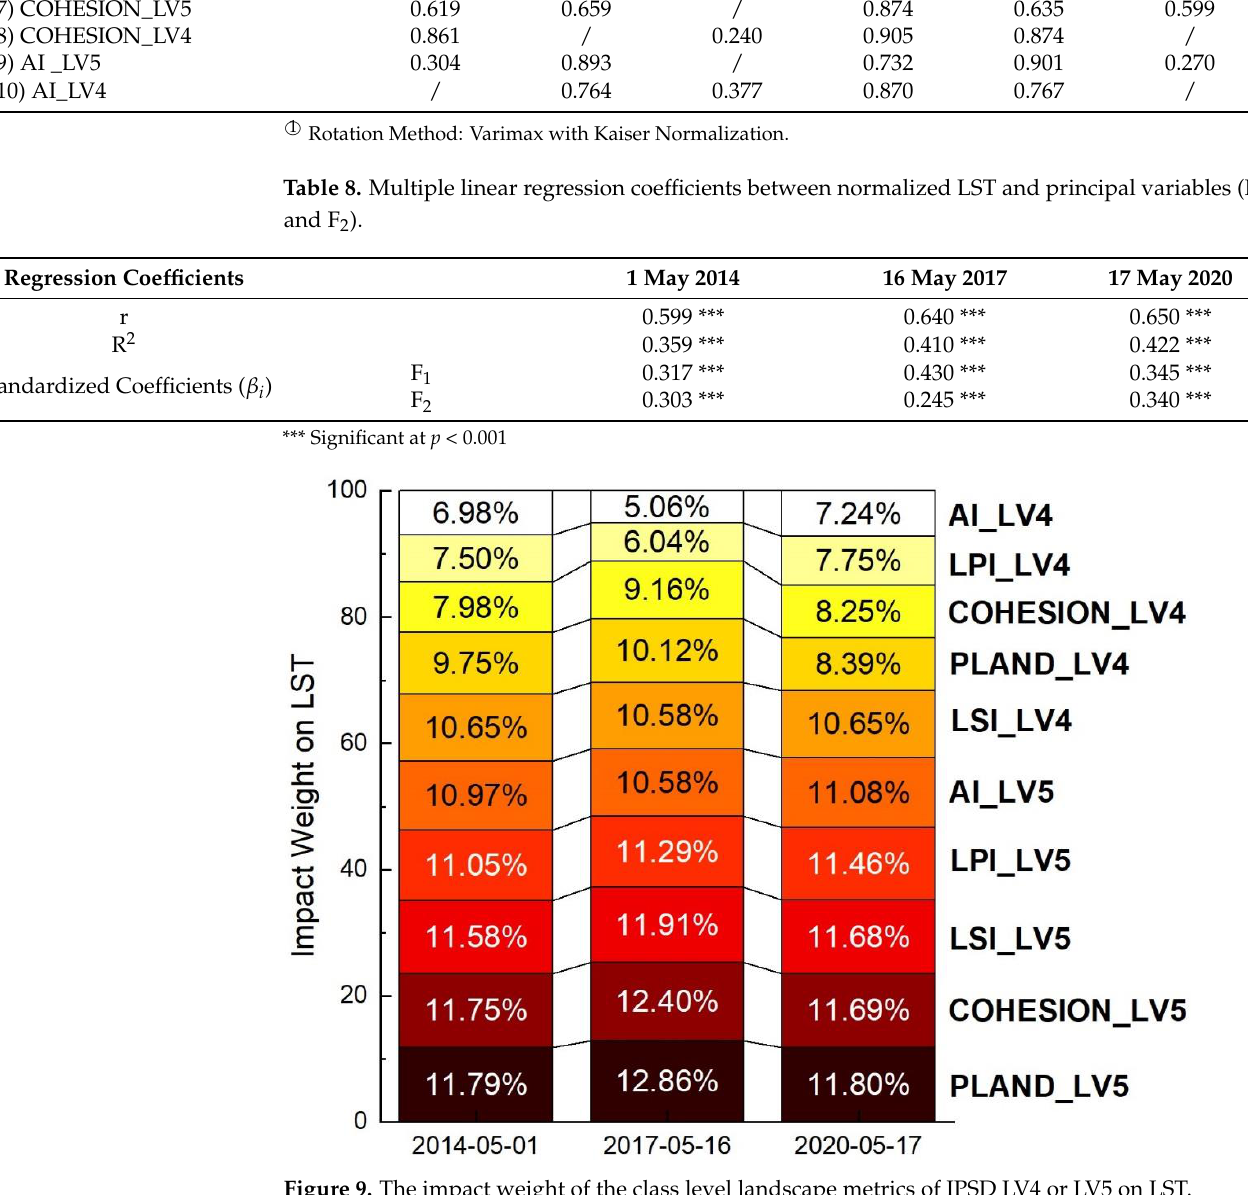
Table 8. Multiple linear regression coefficients between normalized LST and principal variables (F 1 and F 2 ).